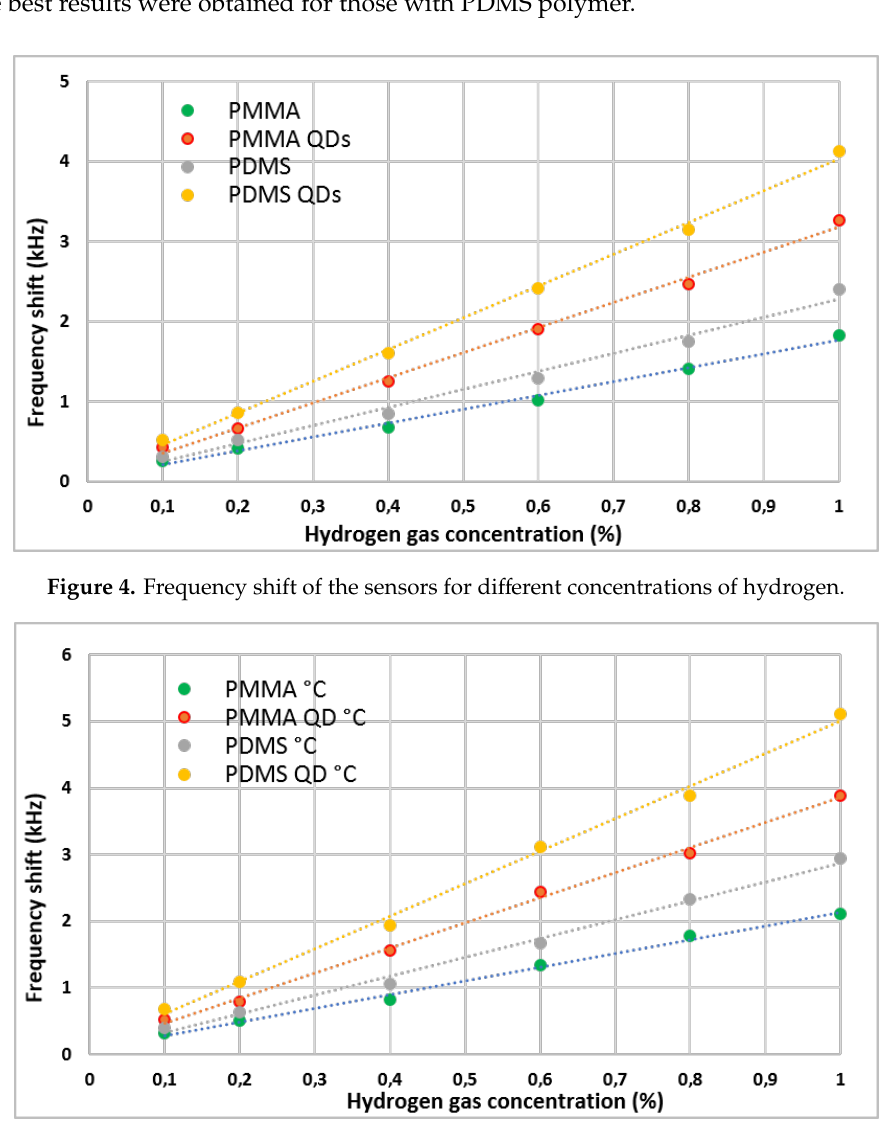
5 of 10 Table 2. Sensitivity and limit of detection (LOD) fo r the sensitive films. Legend: Δf, frequency change; c, hydrogen concentration. Sensor